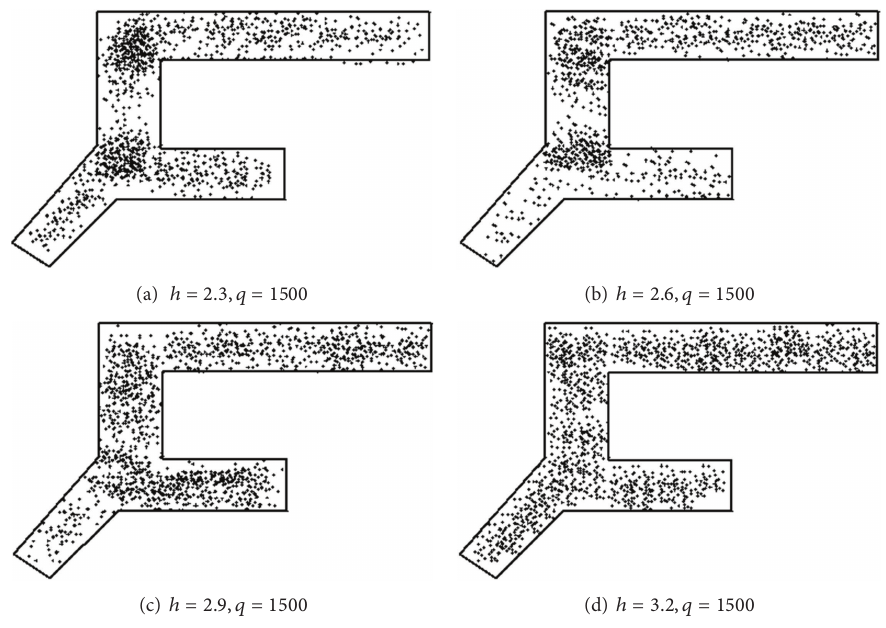
Figure 16: Inner space status of signs at different heights ( 𝑞 = 1500 ).